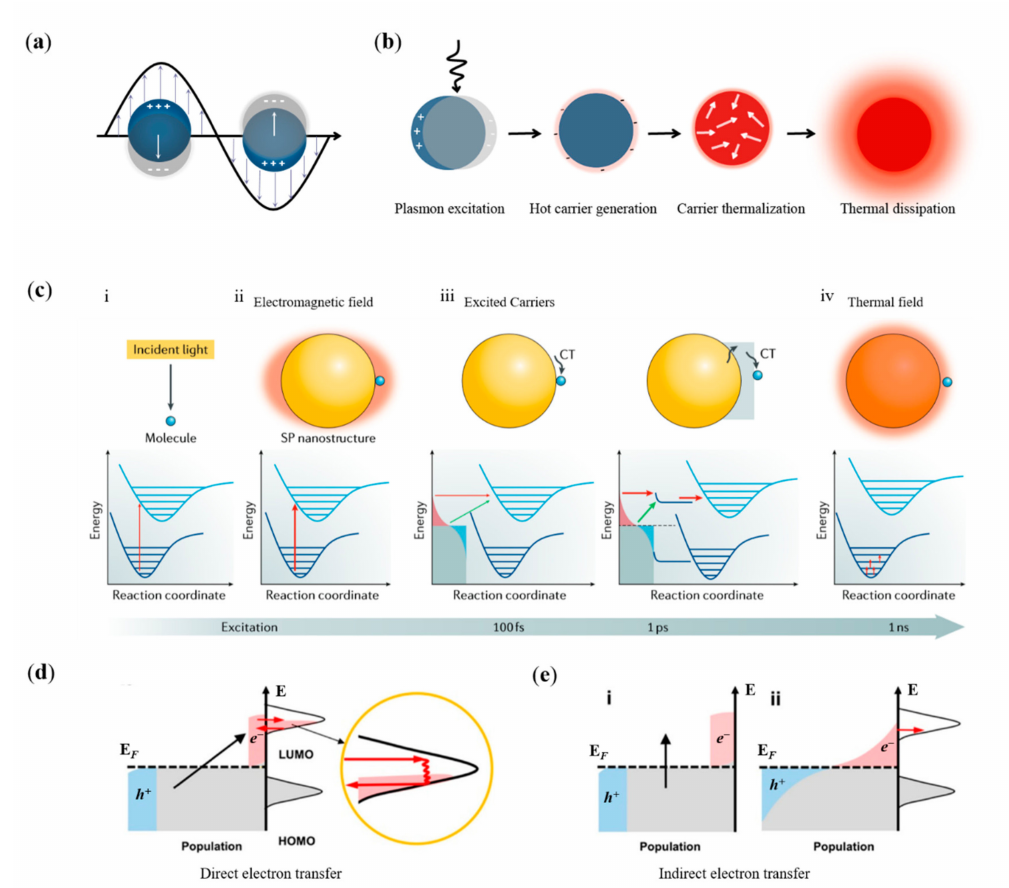
Figure 1. ( a ) Coherent oscillation of electrons and the enhanced EM field [23]; ( b ) Scheme illustration of SPR excitation and relaxation [5]; ( c ) Catalytic effects of photon (i), plasmonic EM field (ii), hot carrier transfers (iii) and plamsonic thermal field (iv) [18]. Direct ( d ) and indirect hot carriers transfer ( e ) between metal nanostructure and reactants adsorbed on the surface